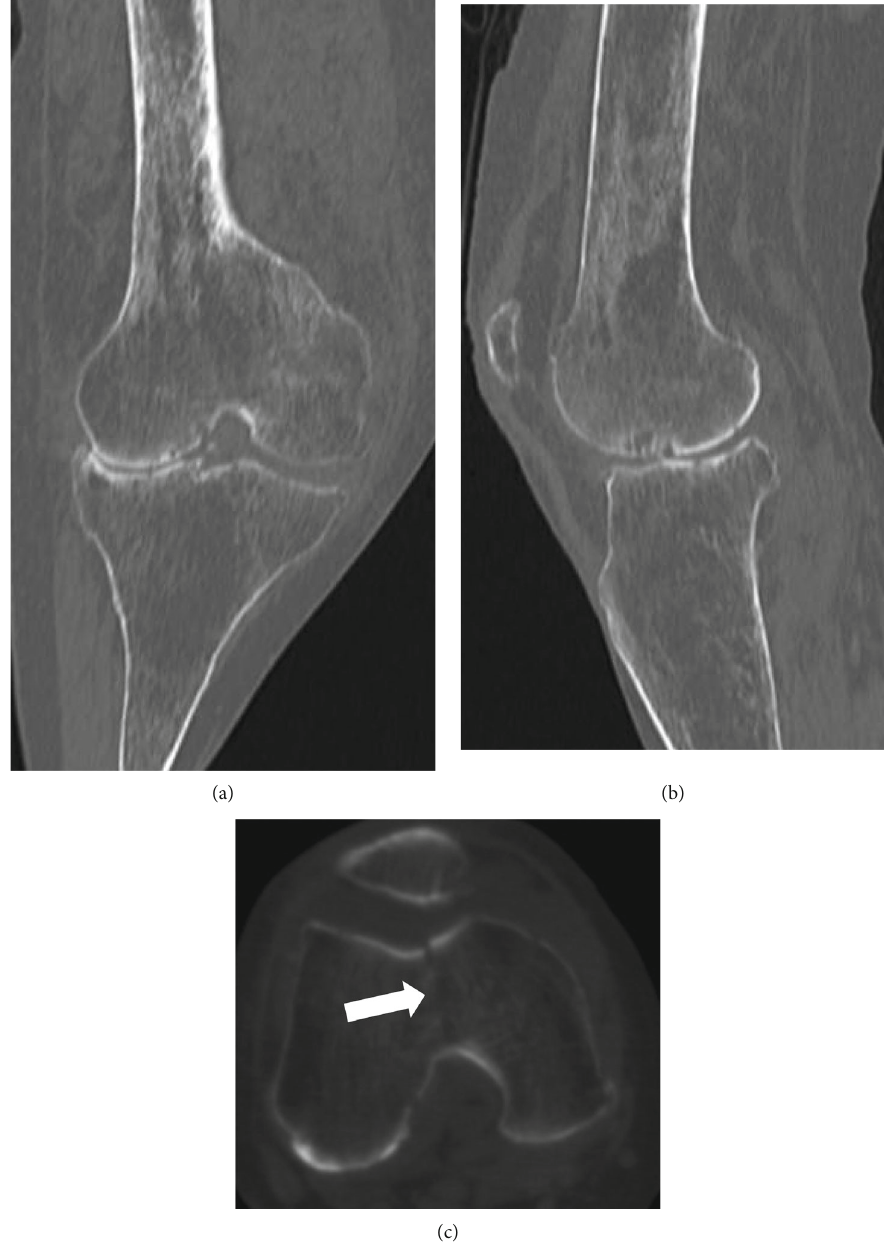
Figure 2: Two dimensional computed tomography (2DCT) scan demonstrating a fracture line from the trochlea to the femoral groove (AO Foundation/Orthopedic Trauma Association classi fi cation: type B2) (white and black arrow). (a) Coronal view, (b) sagittal view, and (c) axial